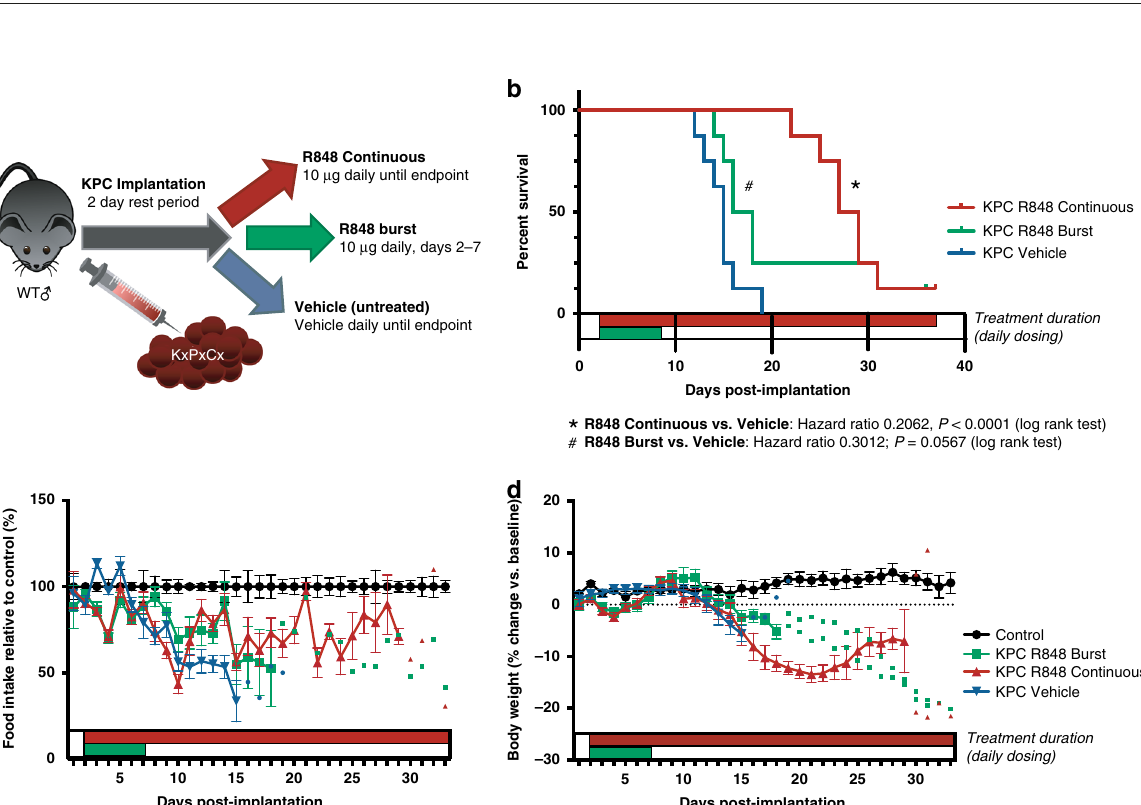
Fig. 4 R848 improves molecular physiology markers related to cachexia. a Lean mass changes assessed by nuclear magnetic resonance (NMR) relaxometry, comparing absolute lean mass before implantation with tumor-free lean mass at end of study. Cell lines include KxPxCx, FC1199, and FC1242. b Fat mass changes assessed by NMR, comparing absolute quantity of fat mass prior to implantation with absolute quantity of fat mass at end of study. Statistics depict signi fi cance as compared with sham-operated vehicle-treated mice unless otherwise designated, via one-way ANOVA with Sidak multiple comparison correction. c Normalized gastrocnemius mass and gene expression of key catabolic transcripts for sham or KxPxCx-implanted animals treated with vehicle (VEH) or R848. d Principle component analysis of all 84 myopathy and myogenesis related transcripts in sham vehicle, and KxPxCx allocated to vehicle or R848. e Unsupervised clustering analysis of all myogenesis and myopathy related transcripts with a fold regulation >2 and adjusted P < 0.05 between groups. Expression values are normalized by SD for each transcript to depict variance from the mean. f Normalized heart mass and cardiac gene expression of catabolic and autophagy transcripts for sham or KxPxCx-implanted animals treated with vehicle (VEH) or R848. Gene expression for hypothalamus ( g ) and liver ( h ) are shown for sham-operated and KxPxCx-implanted mice treated with VEH or R848. Data are depicted as mean ± SEM, with individual data points shown. * P < 0.05; ** P < 0.01; *** P < 0.001; **** P < 0.0001, with the color of symbol matched to the relevant comparison group: black asterisk, vs. sham-VEH; grey asterisk, vs. sham-R848; blue asterisk, vs. KxPxCx-VEH; red asterisk, vs. KxPxCx-R848